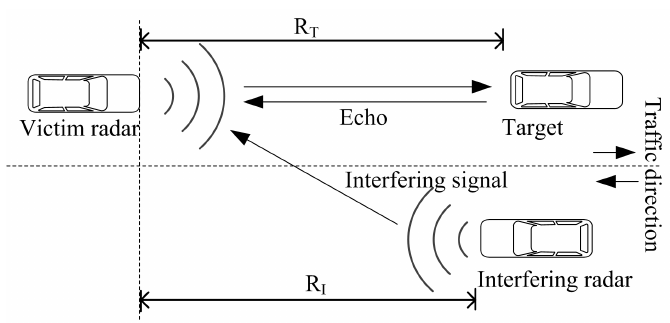
Figure 1. A simplified radar interference model with two lanes in opposite